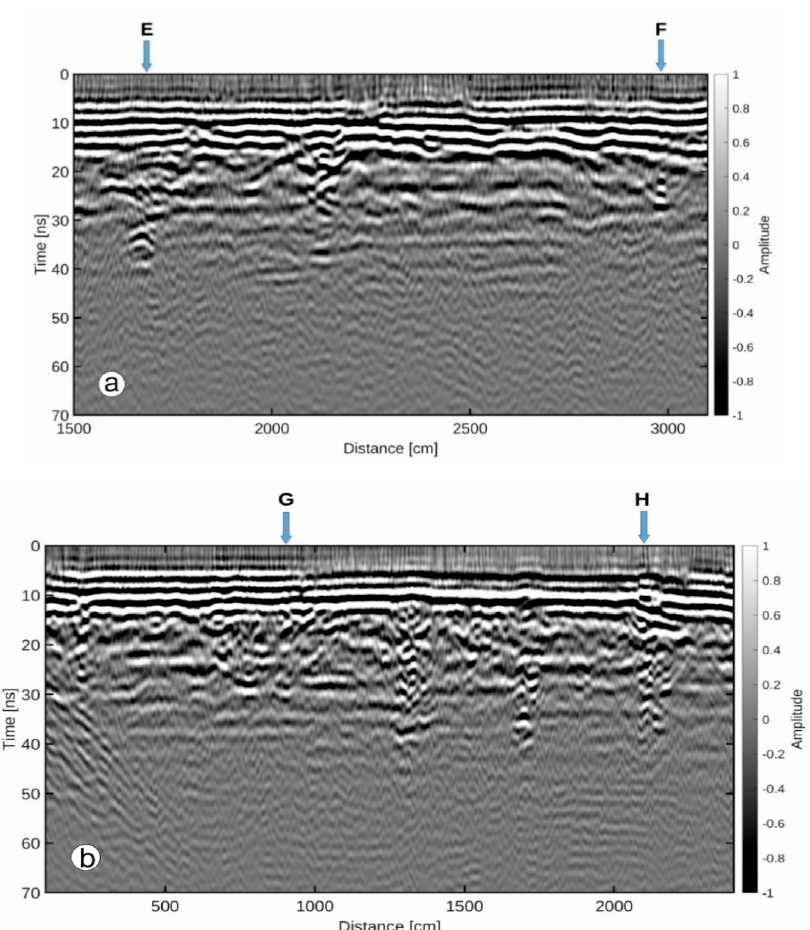
Figure 8. ( a ) The time-migrated section using the 2D picked velocity field of the L74 Line; ( b ) the time-migrated section using the 2D picked velocity field of the L92 line. The diffraction events shown satisfactory collapse at their apex, and the true geometry of the subsurface objects is better-imaged. This is more evident in the close-up of Figure 9a,b pertaining to the L92 line before and after migration, where the arrows indicate some interesting locations. It can be observed that after migration, the dimension of the objects illuminated by the electromagnetic energy is laterally well- delimited, thus giving a more realistic description of the size and shape of the buried targets. Moreover, thanks to the multi-channel (multi-trace) filtering process operated by the migration operator, random noise is reduced after migration.